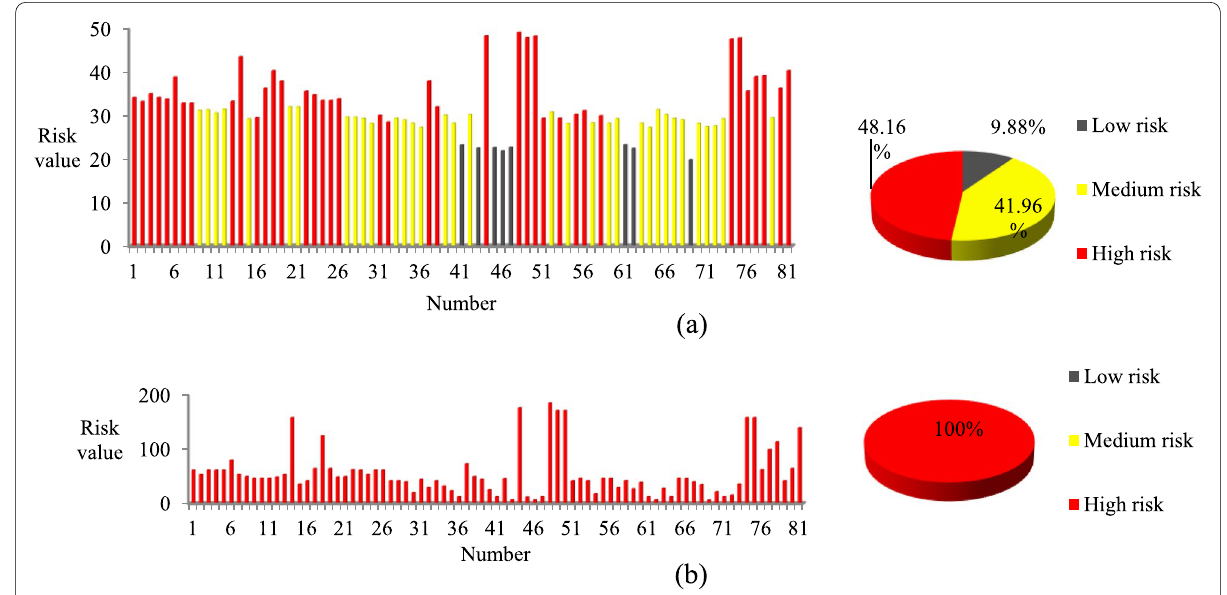
Fig. 8 Comparison of assessment results of ( a ) method 1 and ( b ) method